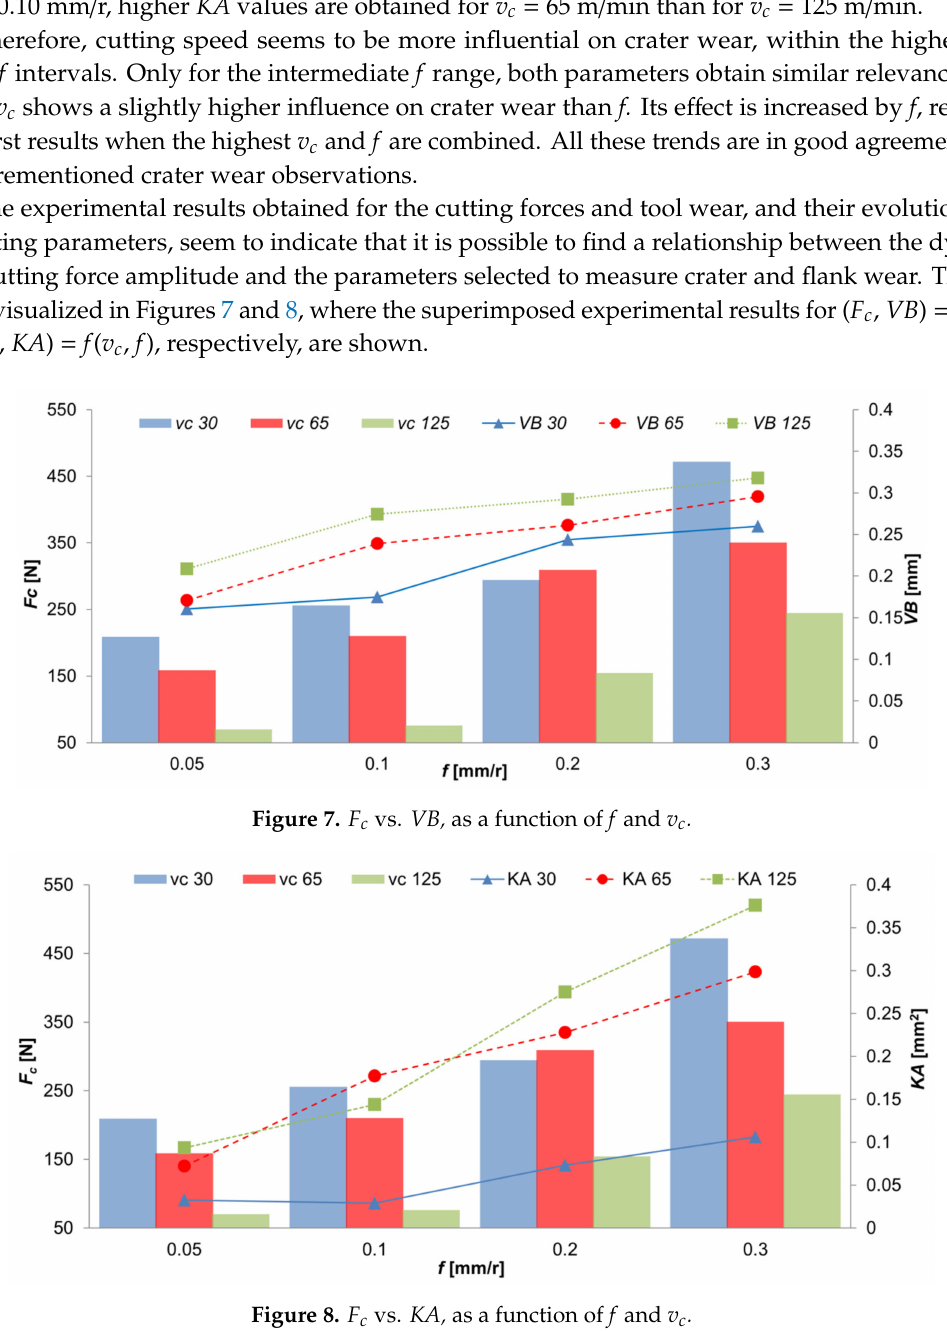
Figure 8. F c vs. KA, as a function of f and v c